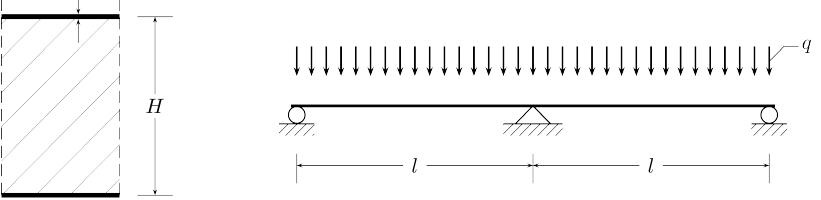
Figure 4. Bending problem for the Timoshenko